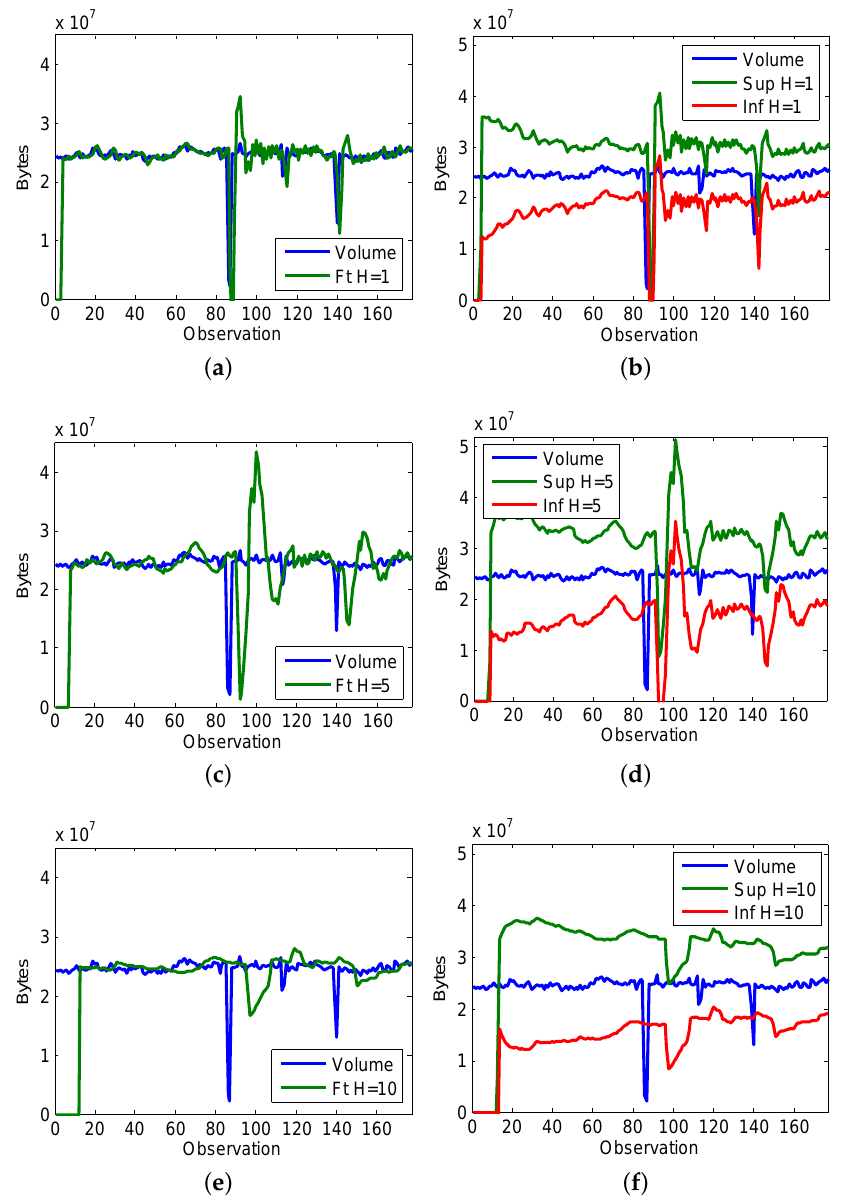
Figure 5. Evolution of prediction and adaptive thresholding on CAIDA’16 sample. ( a ) Forecast H = 1; ( b ) Threhsolding H = 1; ( c ) Forecast H = 5; ( d ) Threhsolding H = 5; ( e ) Forecast H = 10; ( f ) Threhsolding H =